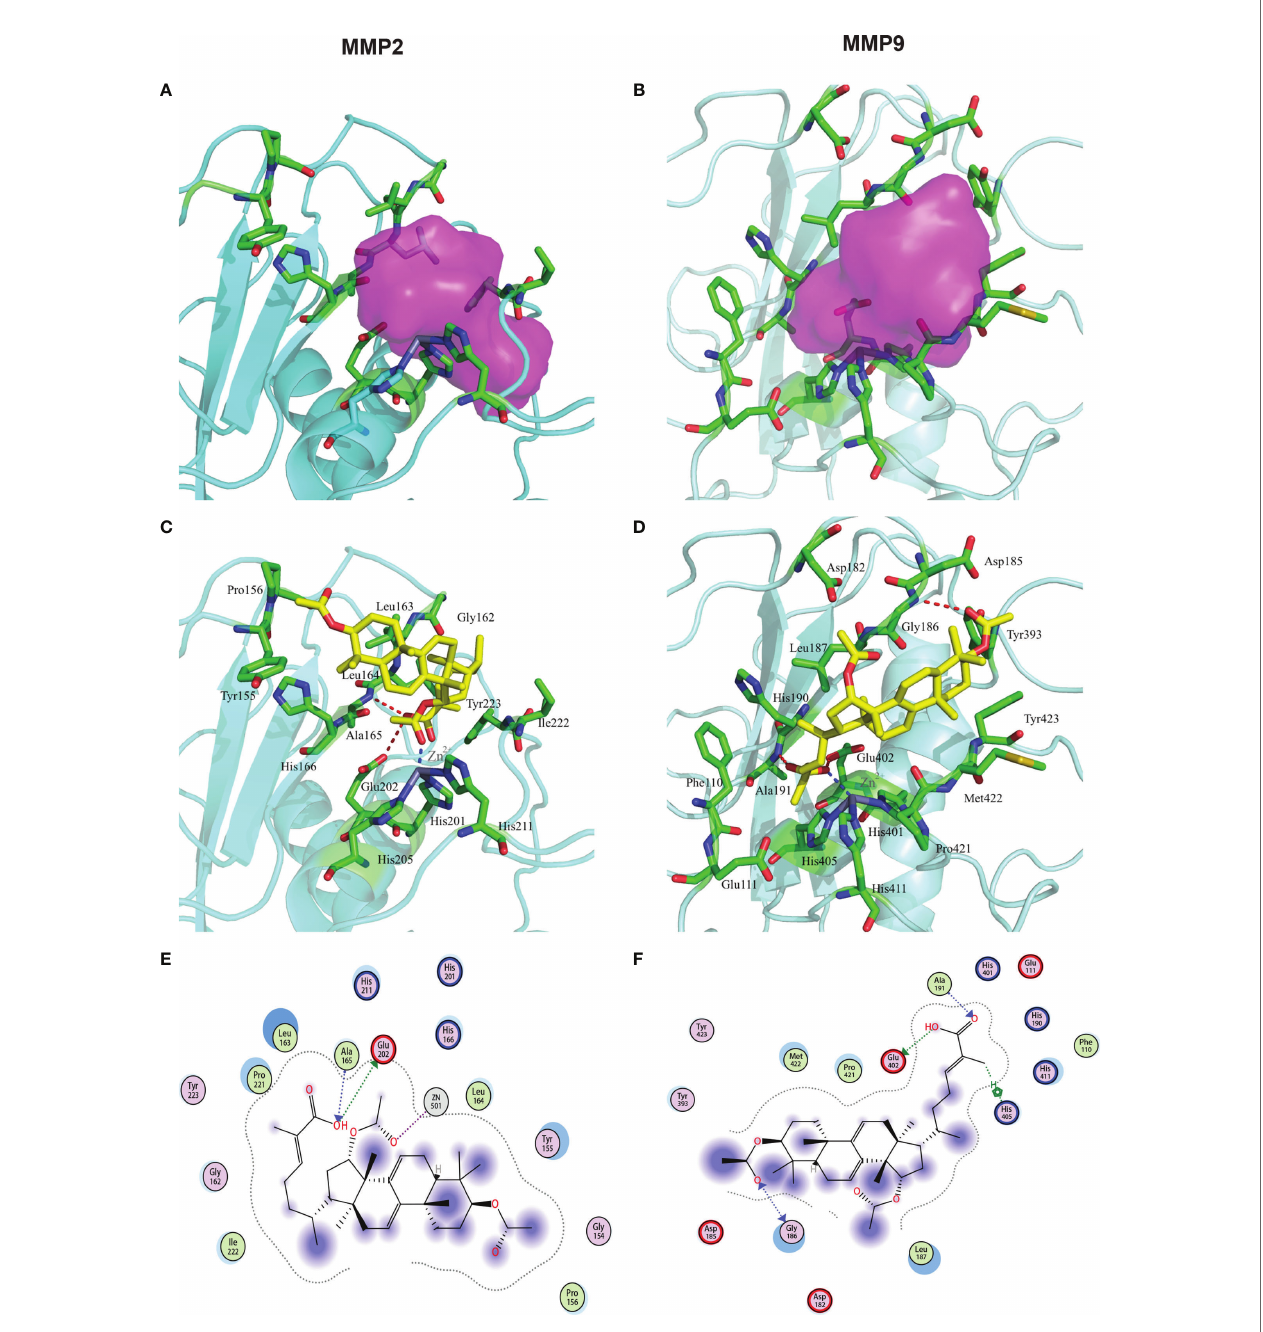
FIGURE 7 | Interactions between MMP2/9 and GA-Me. The red dashed lines represent the hydrogen bonds between the ligands and targets. The blue dashed lines represent the metal contact. (A) Pocket information from the MMP2 crystal structure, highlighted in purple. (B) Pocket information from the MMP9 crystal structure, highlighted in purple. (C) The docking results for GA-Me and MMP2. The predicted Kd value of GA-Me is 7.02. (D) The docking results for GA-Me and MMP9. The predicted Kd value of GA-Me is 5.87. (E) 2D visualization of the interactions between GA-Me and MMP2. (F) 2D visualization of the interactions between GA-Me and MMP9. The important residues are 5461 interacting edges were obtained for the PPI network